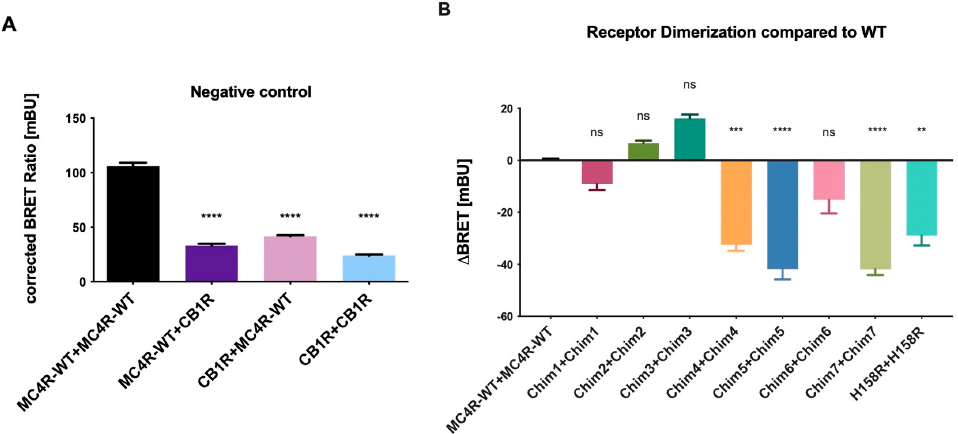
Figure 2. Receptor dimerization of MC4R chimeras compared to MC4R-WT. Dimerization of chimeric MC4R/CB1R receptors and H158R gain of function mutation was analyzed by performing NanoBRET™ assays. HEK293 cells were co-transfected with either BRET partners, C-terminally tagged with the energy donor NanoLuc or the protein tag HaloTag, able to bind the energy acceptor, the NanoBRET TM ligand 618. ( A ) CB1R is a non-interactive partner of MC4R and served as the negative control. Data are shown as BRET ratio in milliBRET units (mBU). ( B ) Δ BRET values were calculated as difference between BRET ratios of chimeras and MC4R-WT. Negative values represent a decrease in dimerization capacities compared to MC4R-WT dimerization. Data represent three independent experiments, each performed in triplicate. Values represent mean ± SEM of calculated BRET ratios. A one-way ANOVA with Kruskal–Wallis test was performed for statistical analysis, and the mean of the WT column was compared to the mean of all the other columns. Statistical significance was defined as ** p < 0.01, *** p < 0.001, and **** p <0.0001.